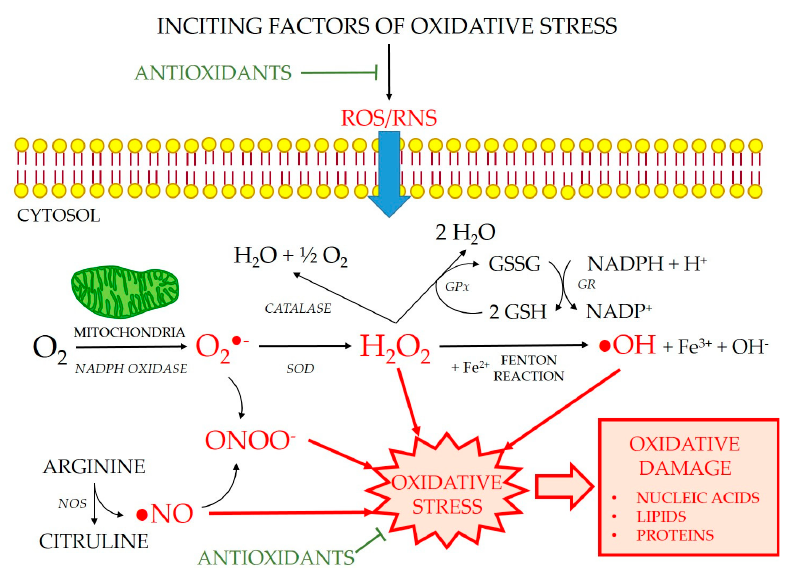
Figure 4. Generation of reactive oxygen and nitrogen species (ROS and RNS). ROS are produced during the normal aerobic cell metabolism. Superoxide anion (O 2 •− ) is formed from oxygen (O 2 ) mainly in the mitochondria. O 2 •− either reacts rapidly with nitric oxide ( • NO) to produce toxic peroxynitrite (ONOO − ) or is catalyzed by superoxide dismutase (SOD) to generate hydrogen peroxide (H 2 O 2 ), which can be neutralized by catalase or glutathione peroxidase (GPx). In presence of transition metal ions, such as ferrous ion, H 2 O 2 forms hydroxyl radicals ( • OH) by the Fenton reaction. GR: glutathione reductase; GSH: reduced glutathione; GSSG: oxidized glutathione; NADP: nicotinamide adenine dinucleotide phosphate; NADPH: reduced NADP; NOS: nitric oxide synthase. Modified from [40].